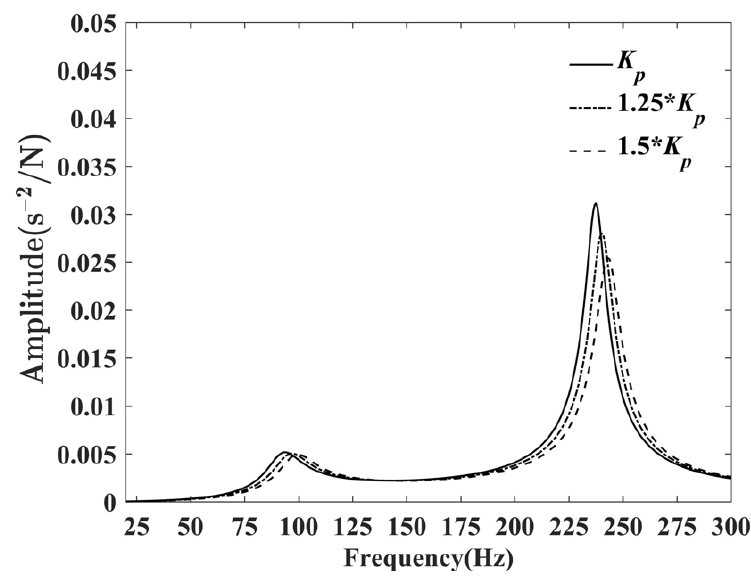
Figure 10. Acceleration frequency response of different K p